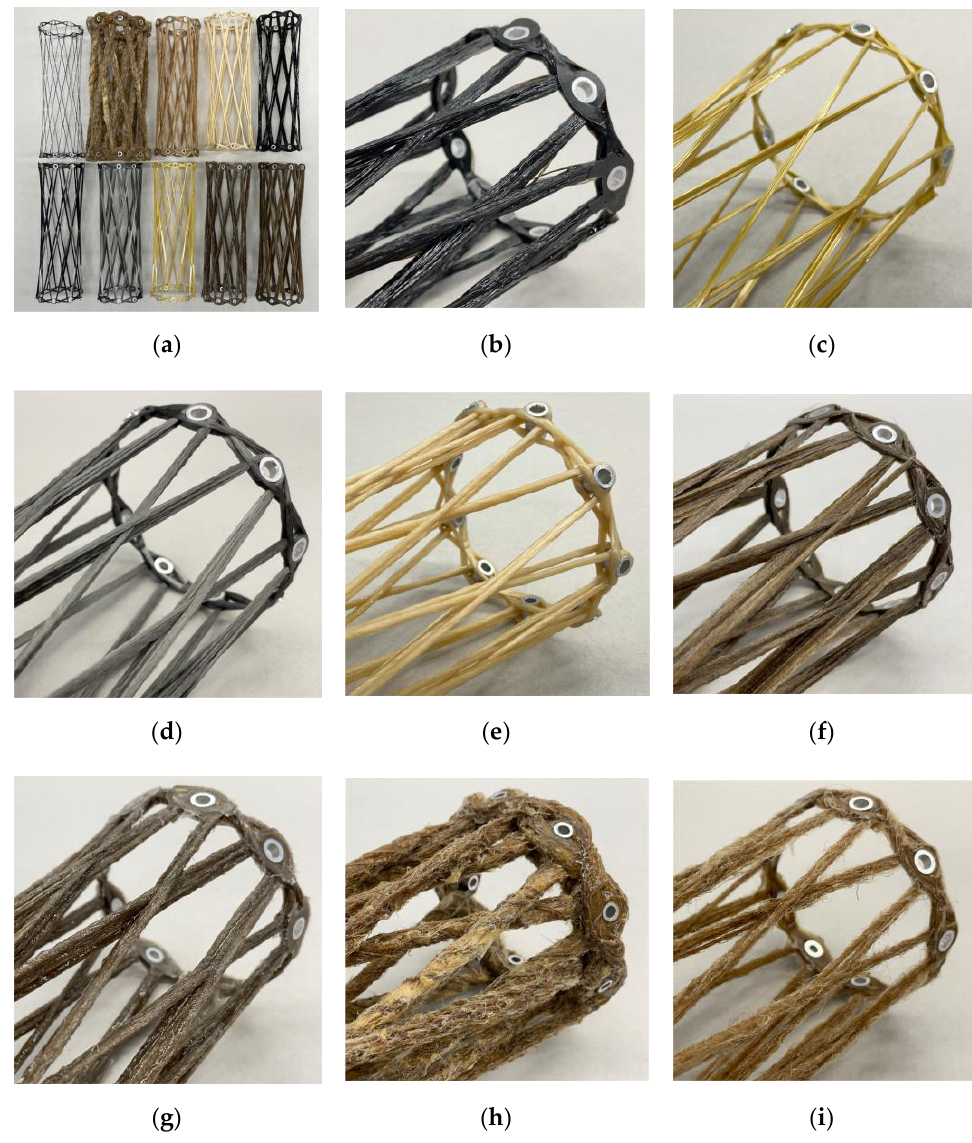
Figure 9. Selection of some of the produced generic cylindrical samples, from left to right and top to bottom: 1 × 6k carbon, hemp, jute, viscose, basalt type 1, 3 × 24K carbon, stainless steel, aramid, flax yarn, and flax tape. ( a ) Size comparison overview; ( b ) basalt; ( c ) aramid; ( d ) stainless steel; ( e ) viscose; ( f ) flax tape; ( g ) flax yarn; ( h ) hemp; ( i ) jute.